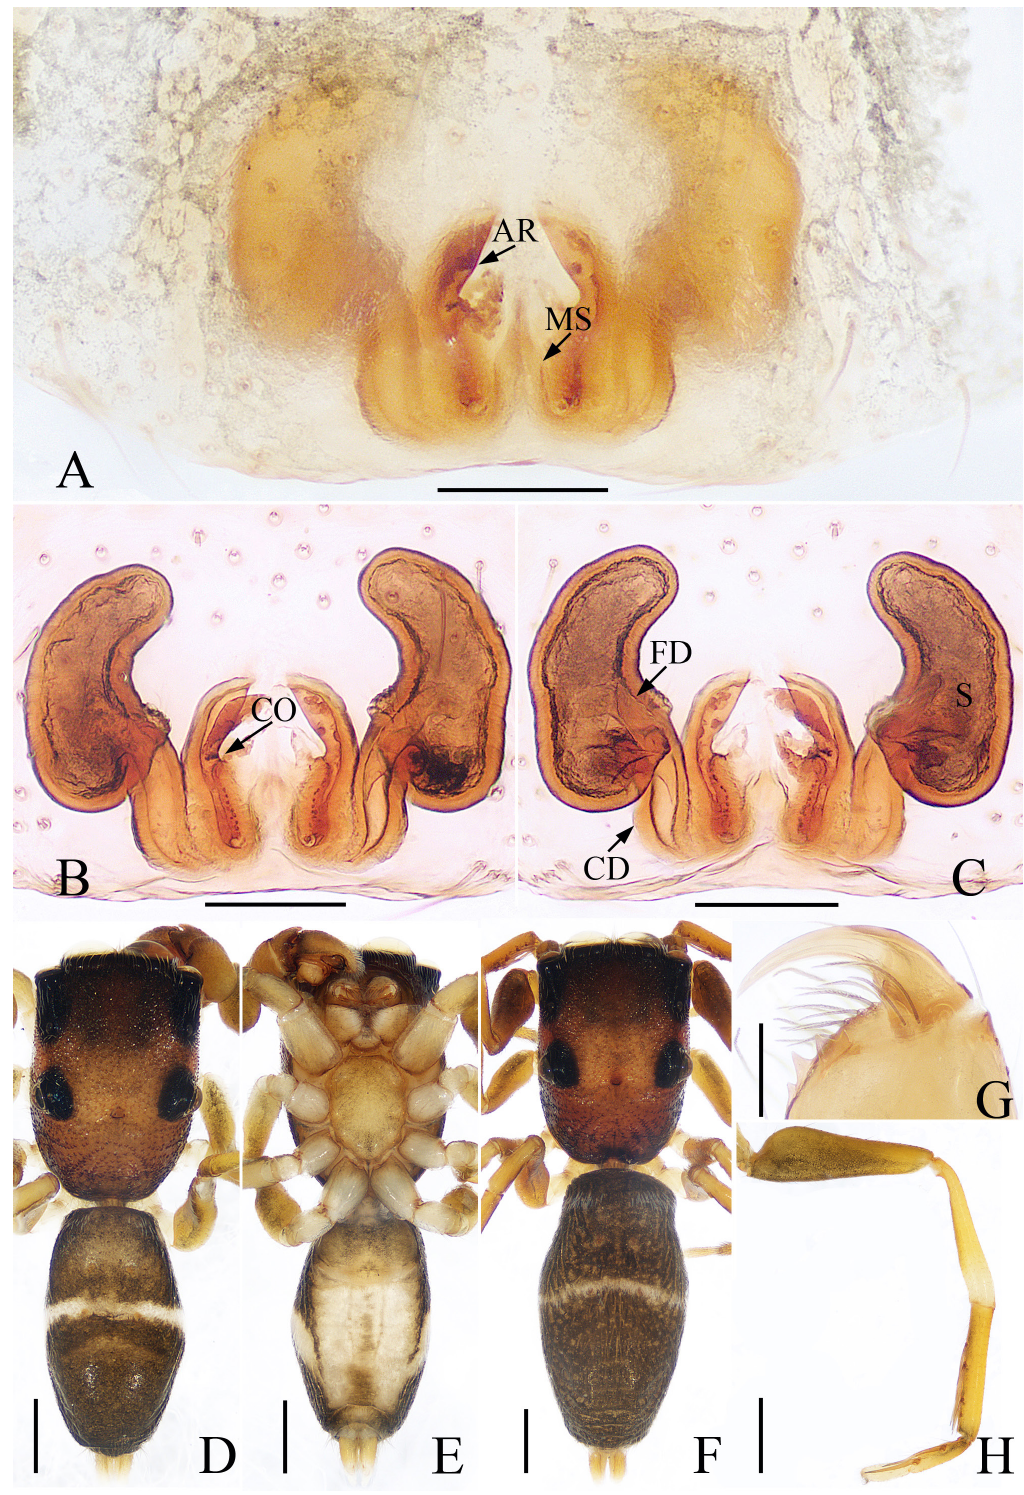
Fig. 16. Synagelides xingdouensis sp. nov. A–C, F . Paratype, ♀ (HNU-20170513-2). D–E, G . Holotype, ♂ (HNU-20170513-1). A – B . Epigyne, ventral view. C . Epigyne, dorsal view. D . Habitus, dorsal view. E . Habitus, ventral view. F . Habitus, dorsal view. G . Chelicerae, dorsal view. H . Leg I, prolateral view. Abbreviations: see Material and methods. Scale bars: A–C, G = 0.1 mm; D–F, H = 0.5